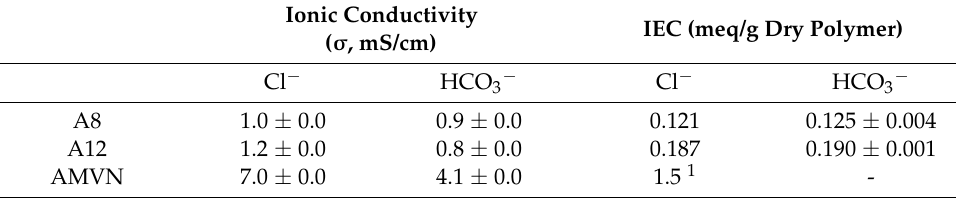
Table 3. Ionic conductivity and IEC of all films.